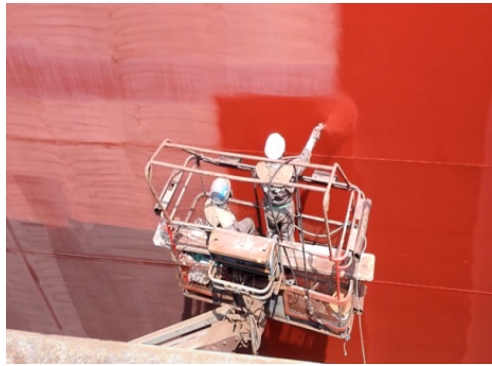
Figure 3. Current status of hull painting work in a shipyard in Dalian. The spraying area, spraying distance, and “zigzag” spray trajectory of the hull outer plate surface in the dock are shown in Figure 4.